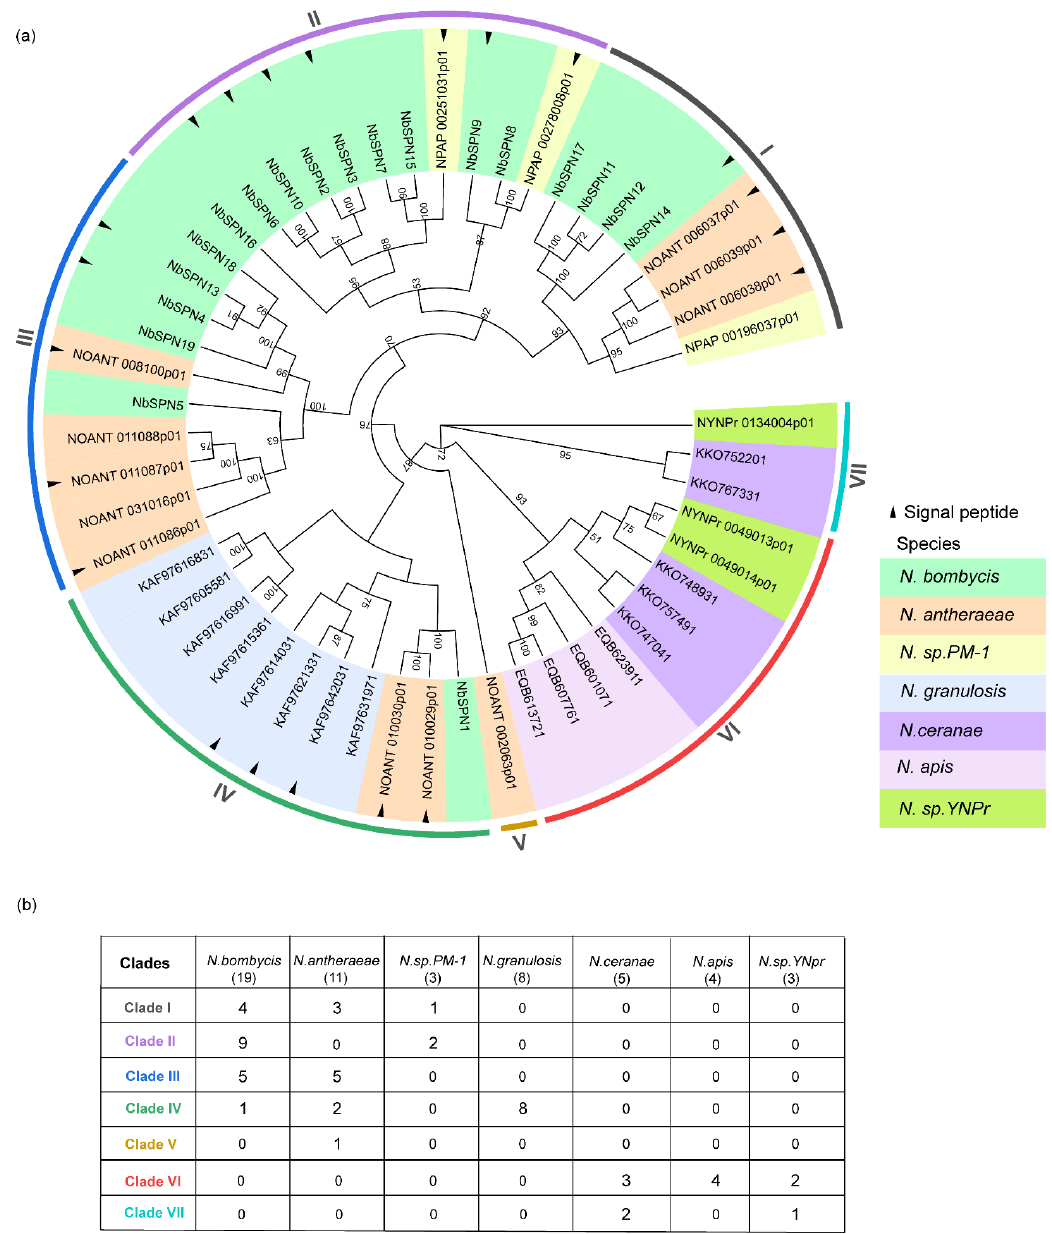
Figure 6. Phylogenetic analysis of serpin genes in microsporidia . ( a ) Different colors represent dif- ferent species of serpins. The neighbor-joining phylogenetic tree was based on serpin protein se- quences using MEGA-X. The analysis was conducted on 1000 bootstrapped datasets. Serpins with the predicted signal peptides (SignalP-5.0 Online: https://services. healthtech.dtu.dk/service.php SignalP-5.0, accessed on 4 October 2022) were labeled with a black triangle. ( b ) The table records each species ’ serpin numbers in seven clades in detail.